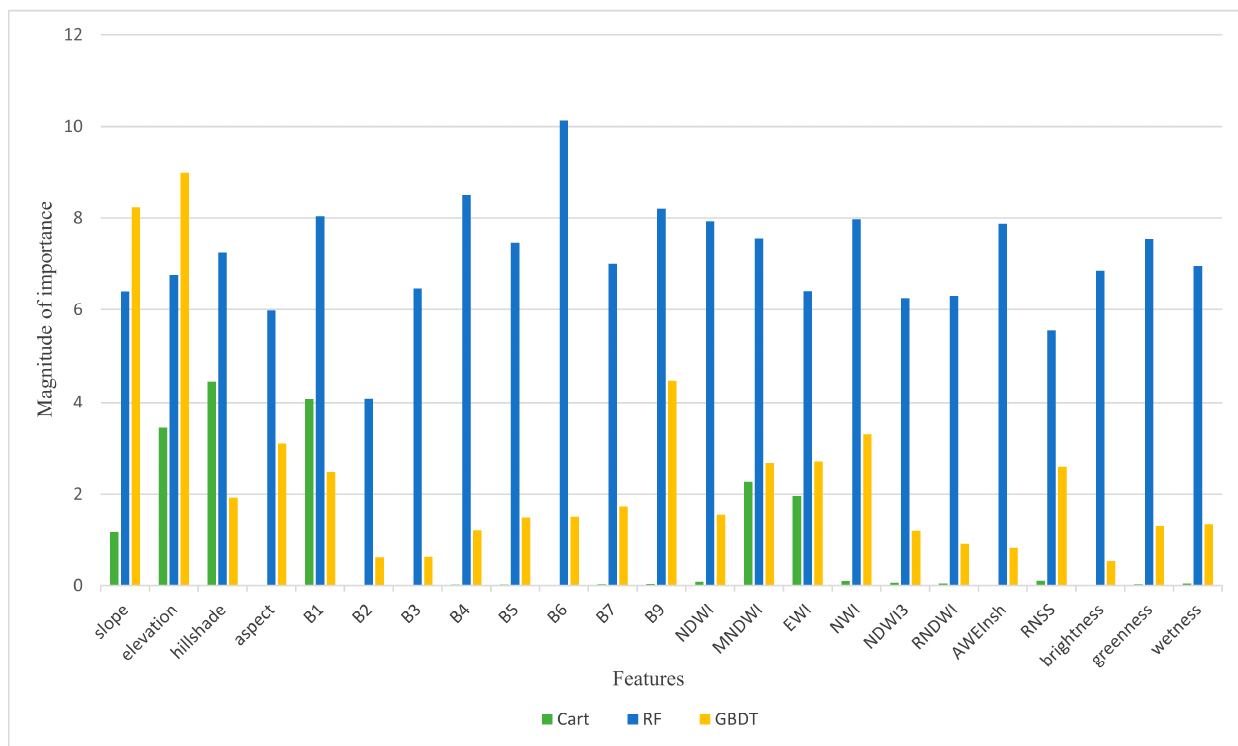
Figure 4. The importance of extracting features of lakes on the Tibetan Plateau in 2021.